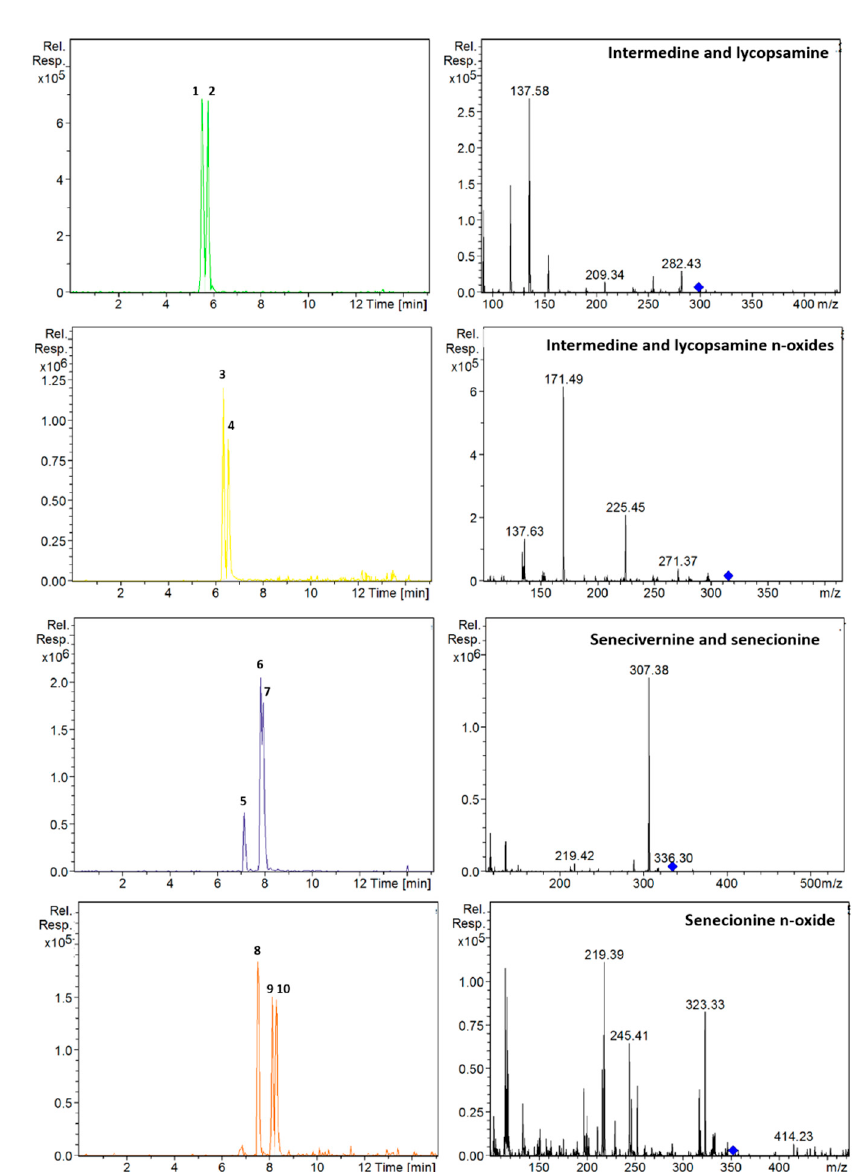
Figure 2. Extracted ion chromatograms and mass spectra (MS 2 ) of: intermedine (1), lycopsamine (2), intermedine N -oxide (3), lycopsamine N -oxide (4), seneciphylline (5), senecivernine (6), senecionine (7), seneciphylline N -oxide (8), senecivernine N -oxide (9) and senecionine N -oxide (10) in a standard solution containing 100 µg/L of each analyte. Chromatographic conditions as Table 1.